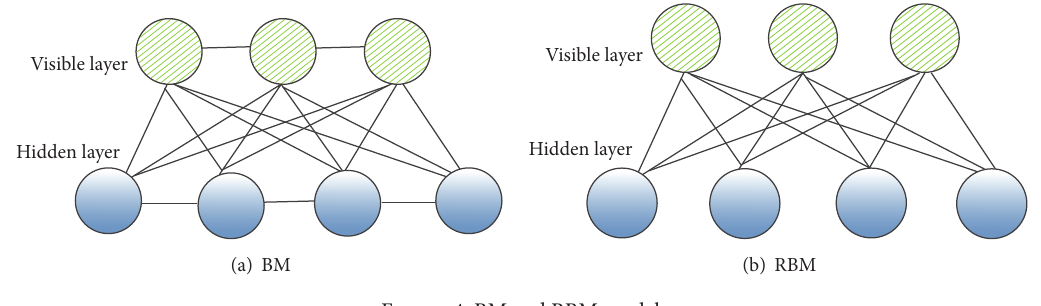
Figure 4: BM and RBM